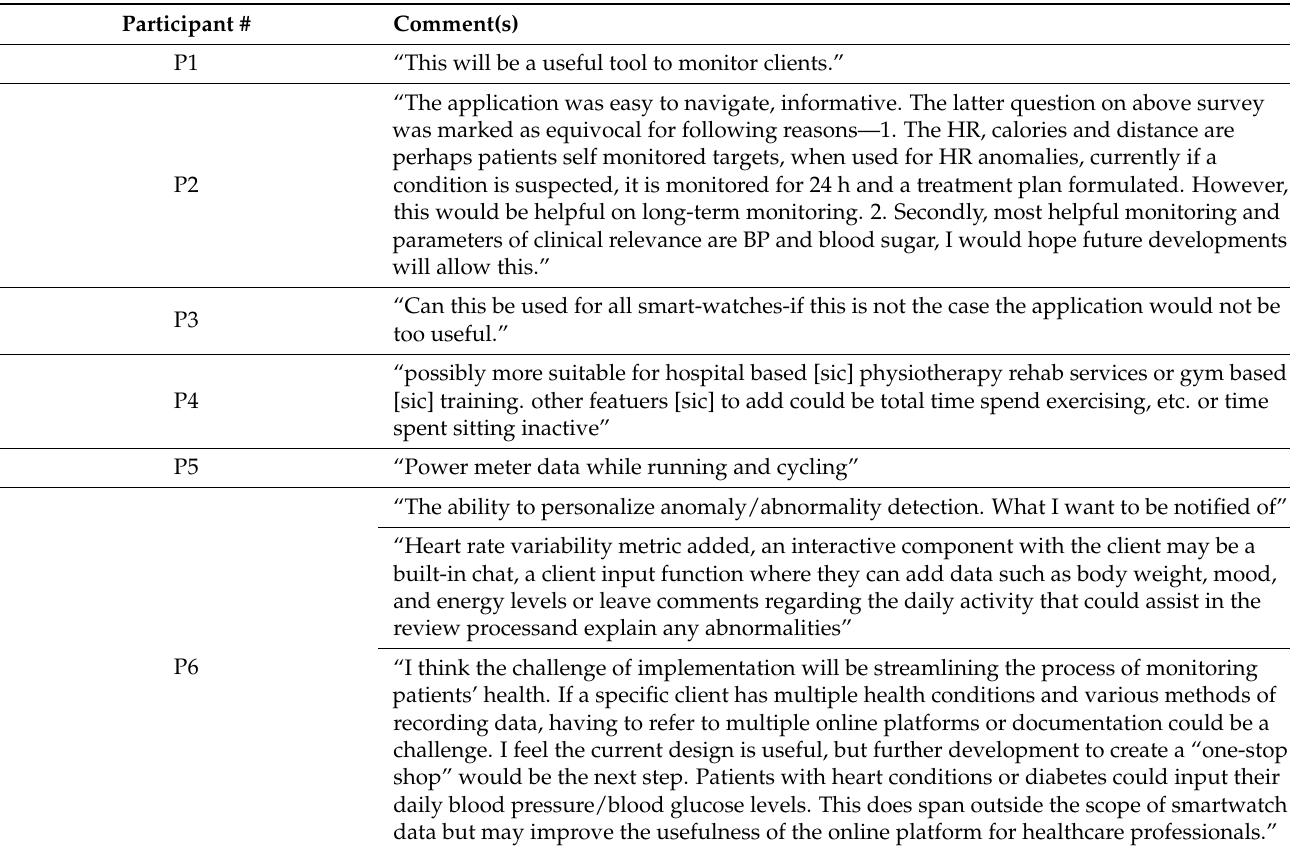
Table 3. Participant’s comments in the evaluation